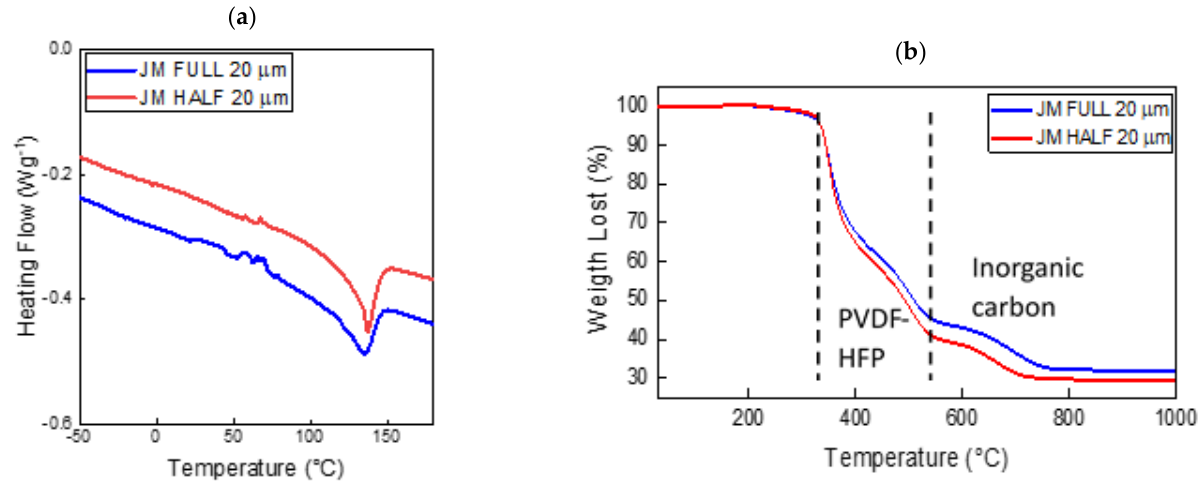
Figure 1. ( a ) DSC thermograms of the 20 µ m HALF and FULL JMs; ( b ) TGA curves of the 20 µ m Figure 1 . ( a ) DSC thermograms of the 20 μ m HALF and FULL JMs; ( b ) TGA curves of the 20 μ m HALF and FULL HALF and FULL JMs.